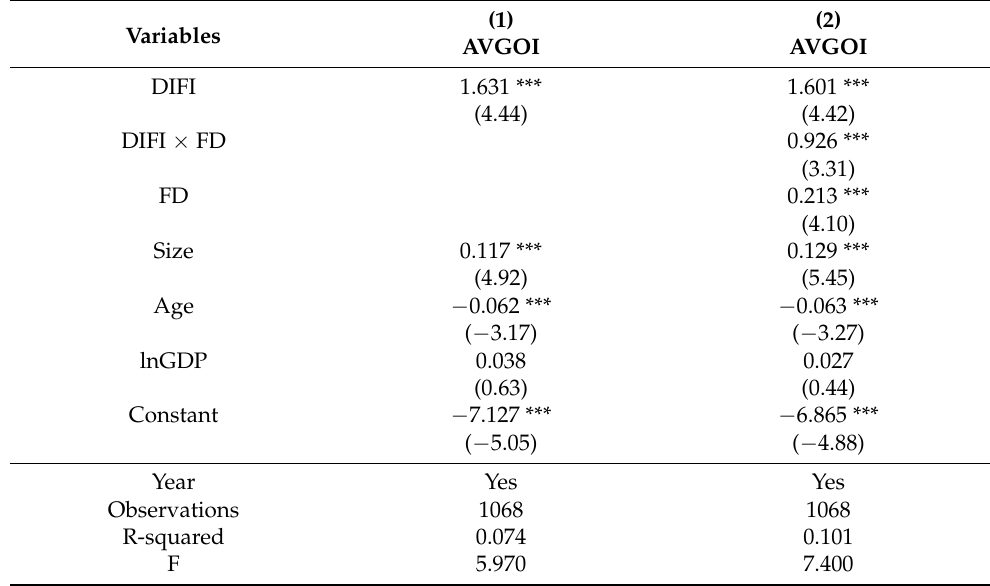
Table 7. Moderating effect of traditional financial